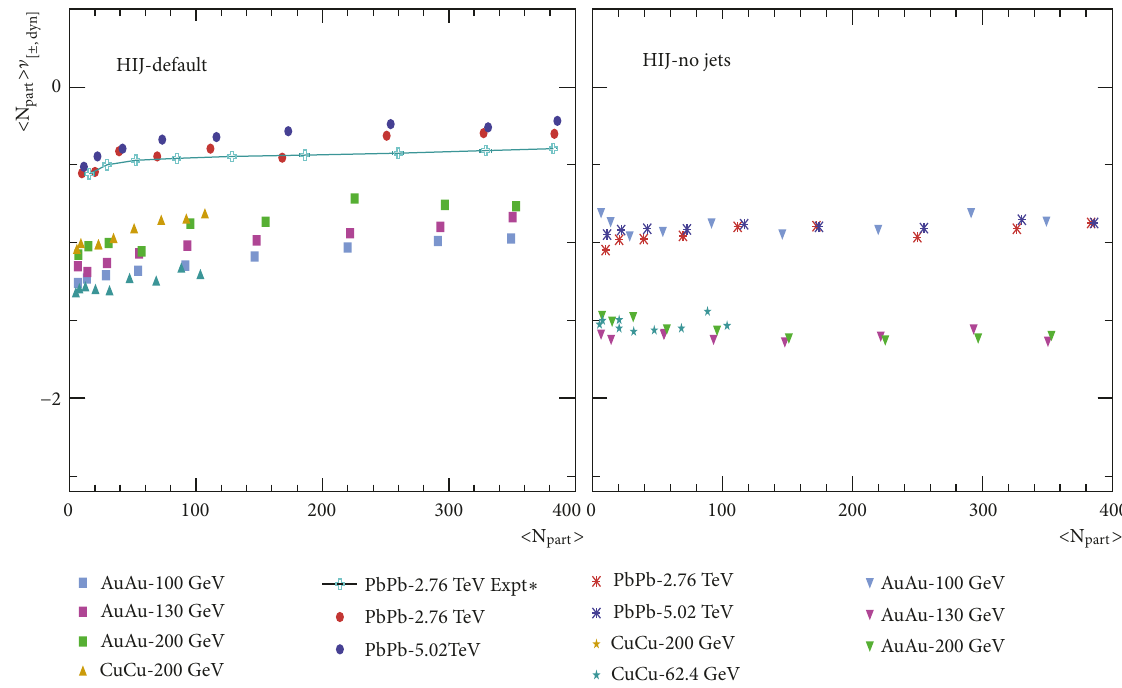
Figure 5: Dependence of product of 𝑁 𝑝𝑎𝑟𝑡 and ] [+−,𝑑𝑦𝑛] on centrality for the two sets of HIJING events at different energies. The line represents the experimental result reported in [17] for √ 𝑠 𝑁𝑁 = 2.76 TeV Pb-Pb